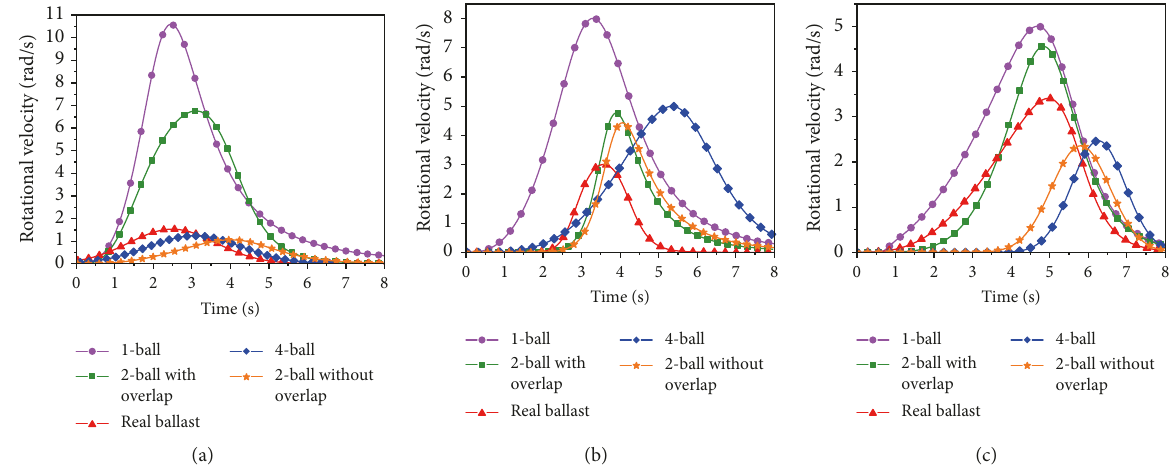
Figure 16: The rotational velocities for particles located at different parts of the cylinder. (a) Bottom part. (b) Middle part. (c) Upper part.